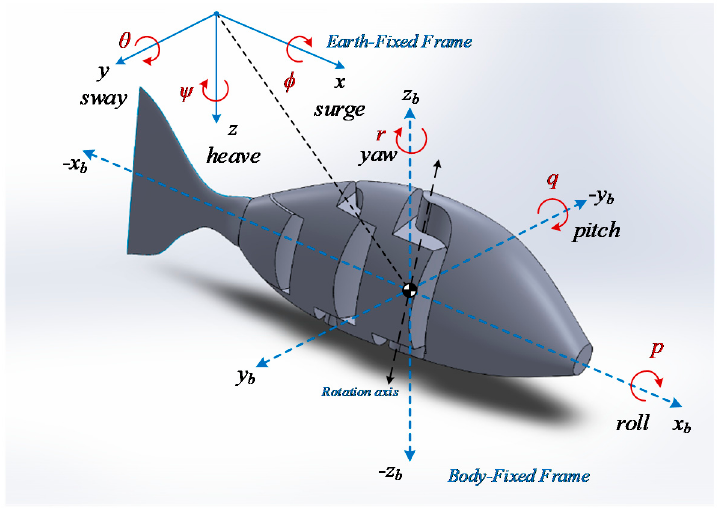
Figure 9. The designed multi-link robotic fish prototype on reference frames.